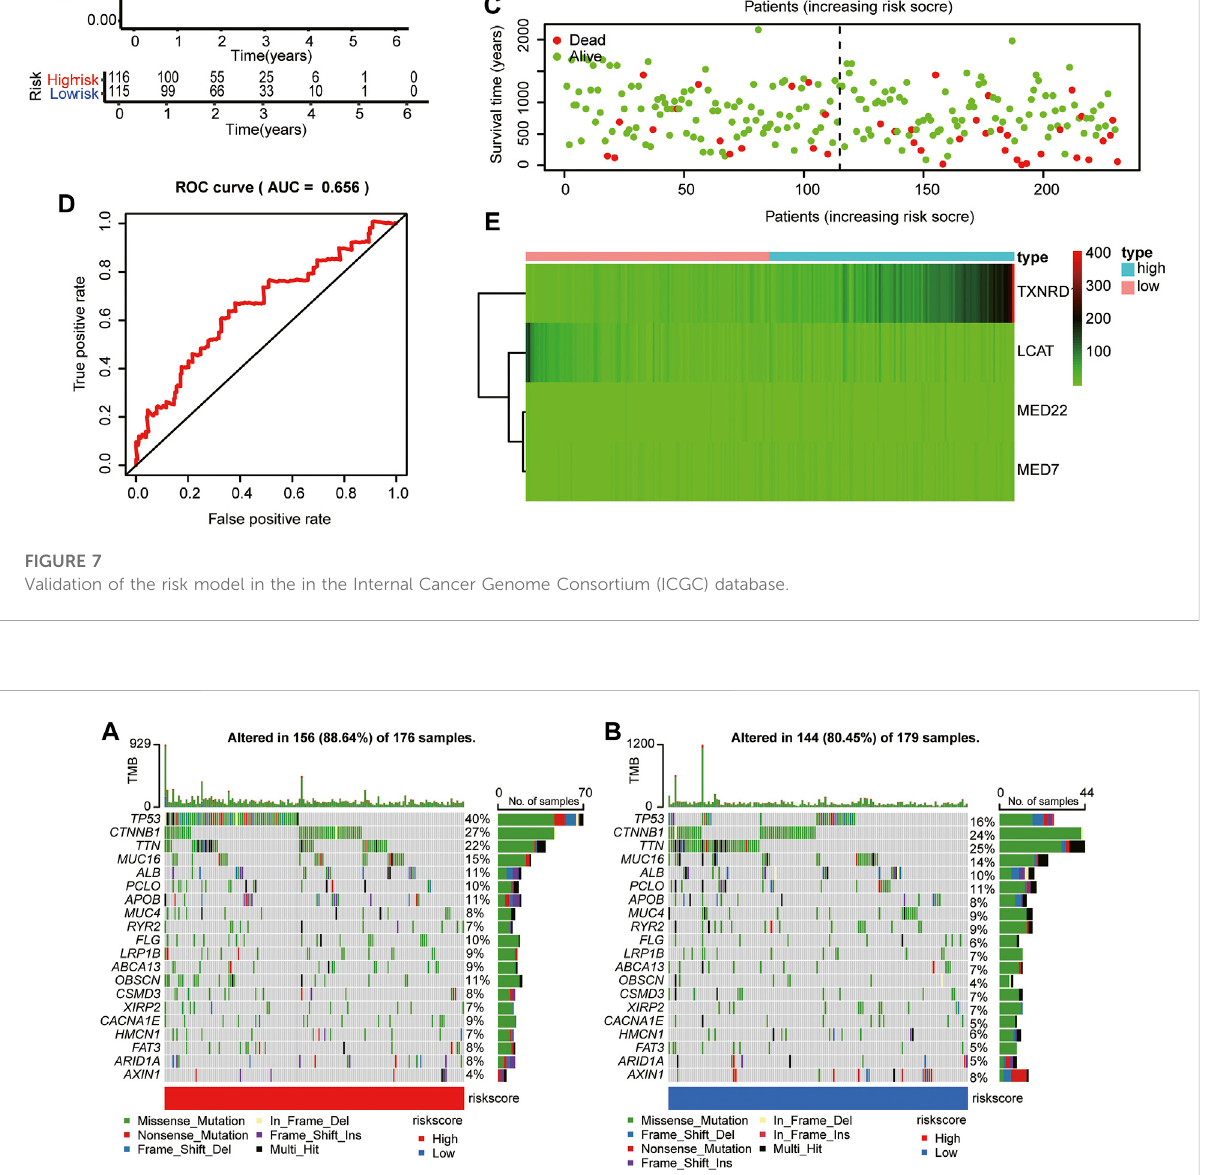
Frontiers in Cell and Developmental